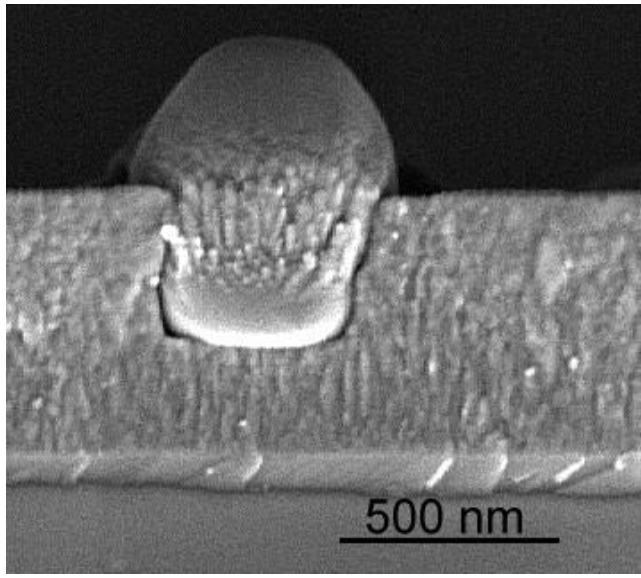
Figure 5 . Cross section of TiO thin film with prominent macroparticle, subsequently 2 partially coated at later stages of the deposition